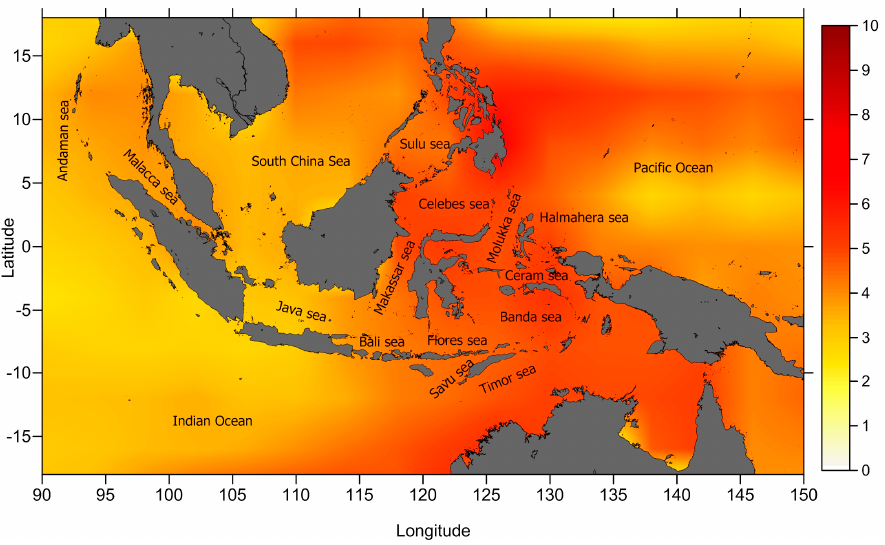
Figure 24. The map of sea level trend (unit in mm/year) around the Indonesian seas, estimated from three different satellite altimeters (T/P, Jason-1 and Jason-2) over 23 years. The map has been computed from the SLA time series of mean cycle values, of 4° × 4° grid, and MSL slope has been determined using least squares.